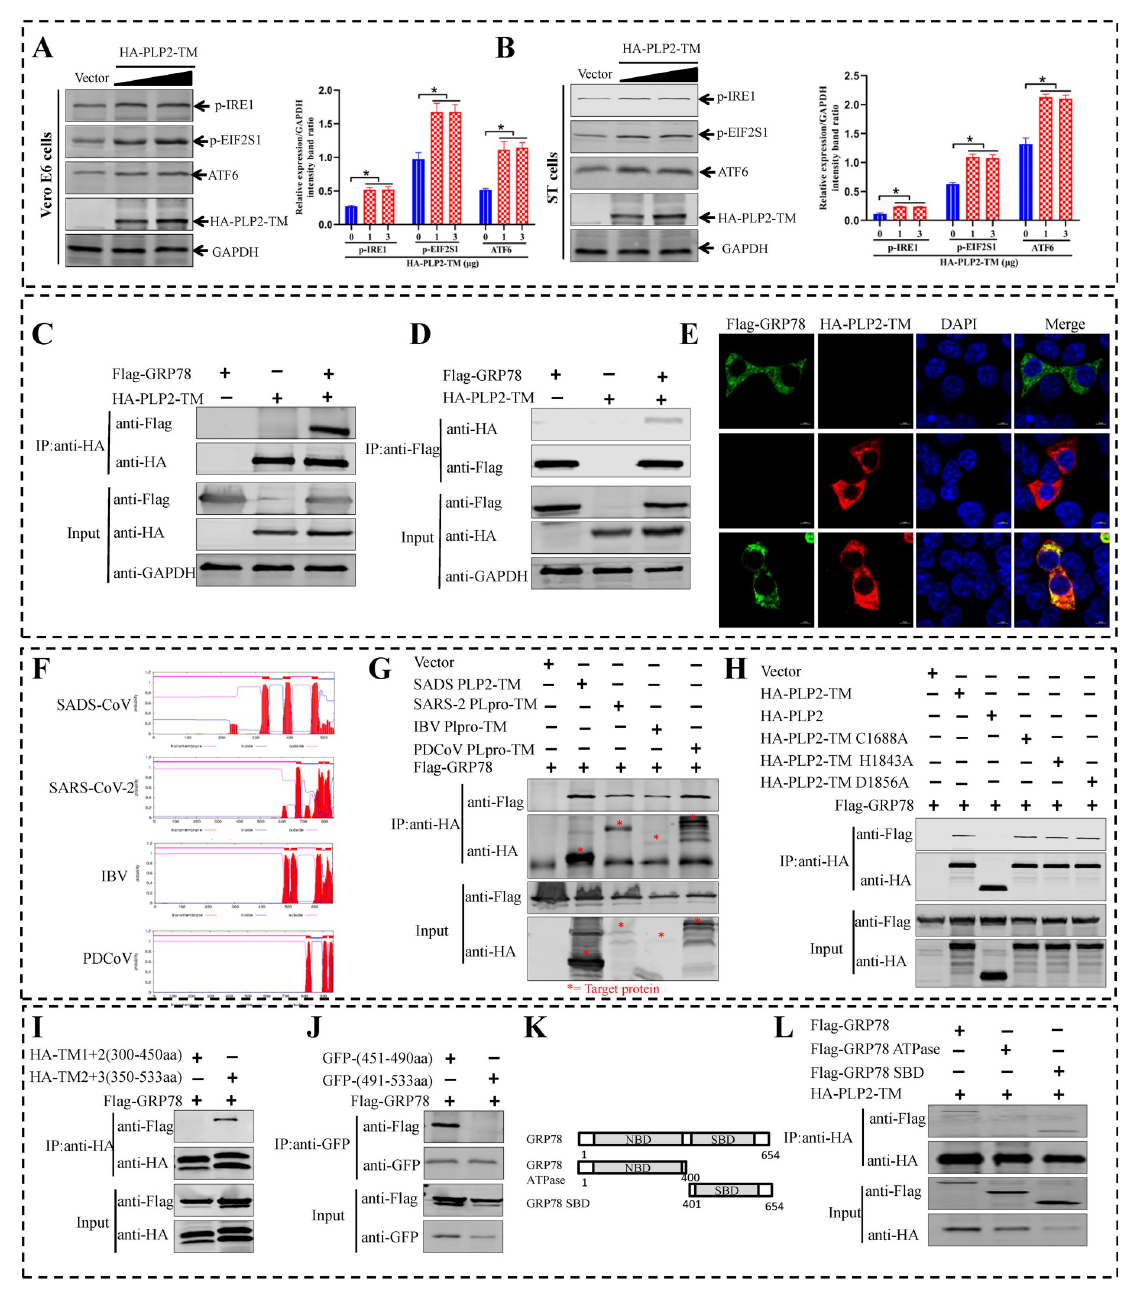
Fig 9. SADS-CoV PLP2-TM activates all three UPR signaling pathways and interaction with GRP78 protein. ( A and B ) Vero E6 and ST cells are transfected with increasing doses of pCAGGS-HA-PLP2-TM. At 36 hpi, western blotting is performed using the indicated antibodies (left panel). Levels of p-IRE1, p-EIF2S1 and cleaved ATF6 relative to the level of GAPDH are determined by a densitometric analysis. Means and SD (error bars) of three independent experiments are indicated ( � P < 0.05). ( C and D ) Co-IP analysis of the interaction between SADS-CoV PLP2-TM protein and GRP78 in HEK293T cells. ( E ) Co-localization of PLP2-TM and GRP78. Vero E6 cells are co-transfected with plasmids expressing HA-PLP2-TM and Flag-GRP78. The PLP2-TM is colored green, and the GRP78 fusion protein is colored red. Merged images are also presented, and the position of the nucleus is indicated by DAPI (blue) staining in the merged images. ( F ) The transmembrane motifs in SADS-CoV ( Alphacoronavirus ), SARS-CoV-2 ( Betacoroavirus ), IBV ( Gammacoronavirus ), and PDCoV ( Deltacoronavirus ) nsp3 proteins are predicted with the online tool TMHMM server, version 2.0. ( G and H ) Co-IP analysis of the interaction between PLPs and GRP78 derived from various coronavirues. The interaction of SADS-CoV PLP2-TM and GRP78 is independent on the protease activity. ( I and J ) The domain of PLP2-TM serving for an interaction with GRP78 is identified. ( K ) Schematics of GRP78 truncations. ( L ) The domain of GRP78 serving for an interaction with PLP2-TM is identified.